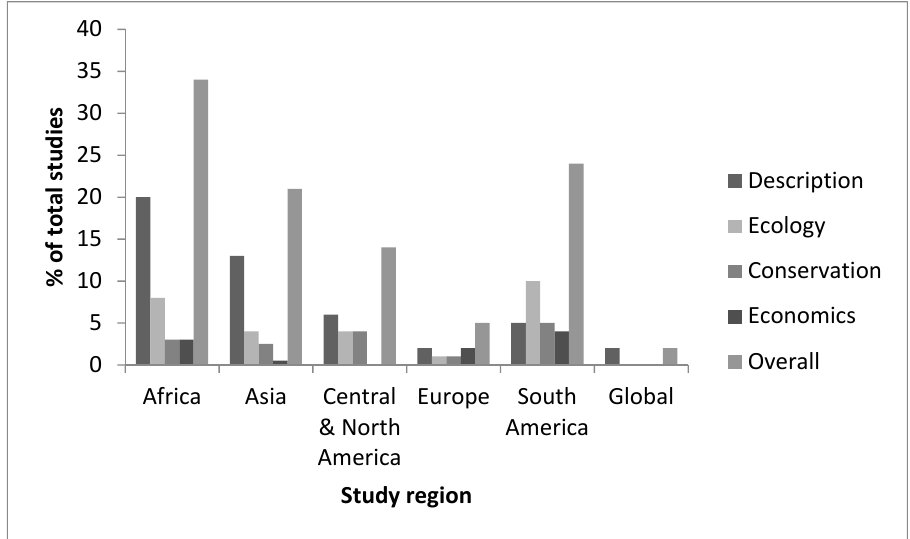
Figure 2. Number of articles per year on wild edible fruits. The count for 2017 was taken in October 2017.